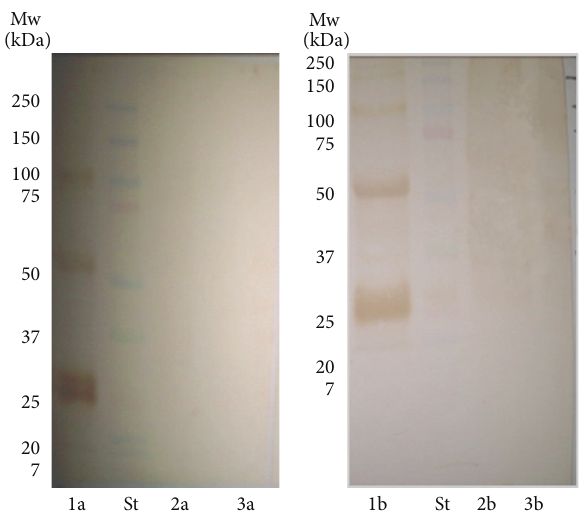
Figure 2: Western blot analysis of the isolated proteins: (1) human peripheral nerve, (2) C. jejuni O:19-GBS, and (3) C. jejuni O:19- enteritis, incubated with serum from patient with (a) MND and (b)